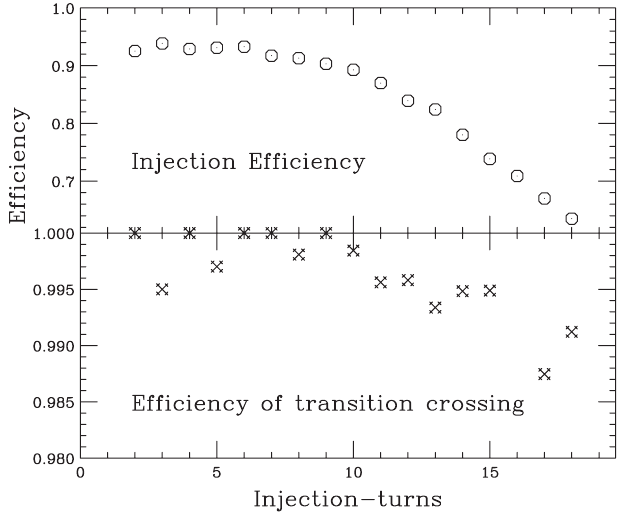
FIG. 2. The injection efficiency is defined as the ratio of the total charge at revolution 5000 divided by the total charge at injection excluding the 3 bunches intentionally kicked out. Note that the injection is nearly independent of the injection turn when the injection turn is less than 10. The efficiency for transition- energy crossing is defined as the ratio of the total charge at revolution 10 010 and that at revolution